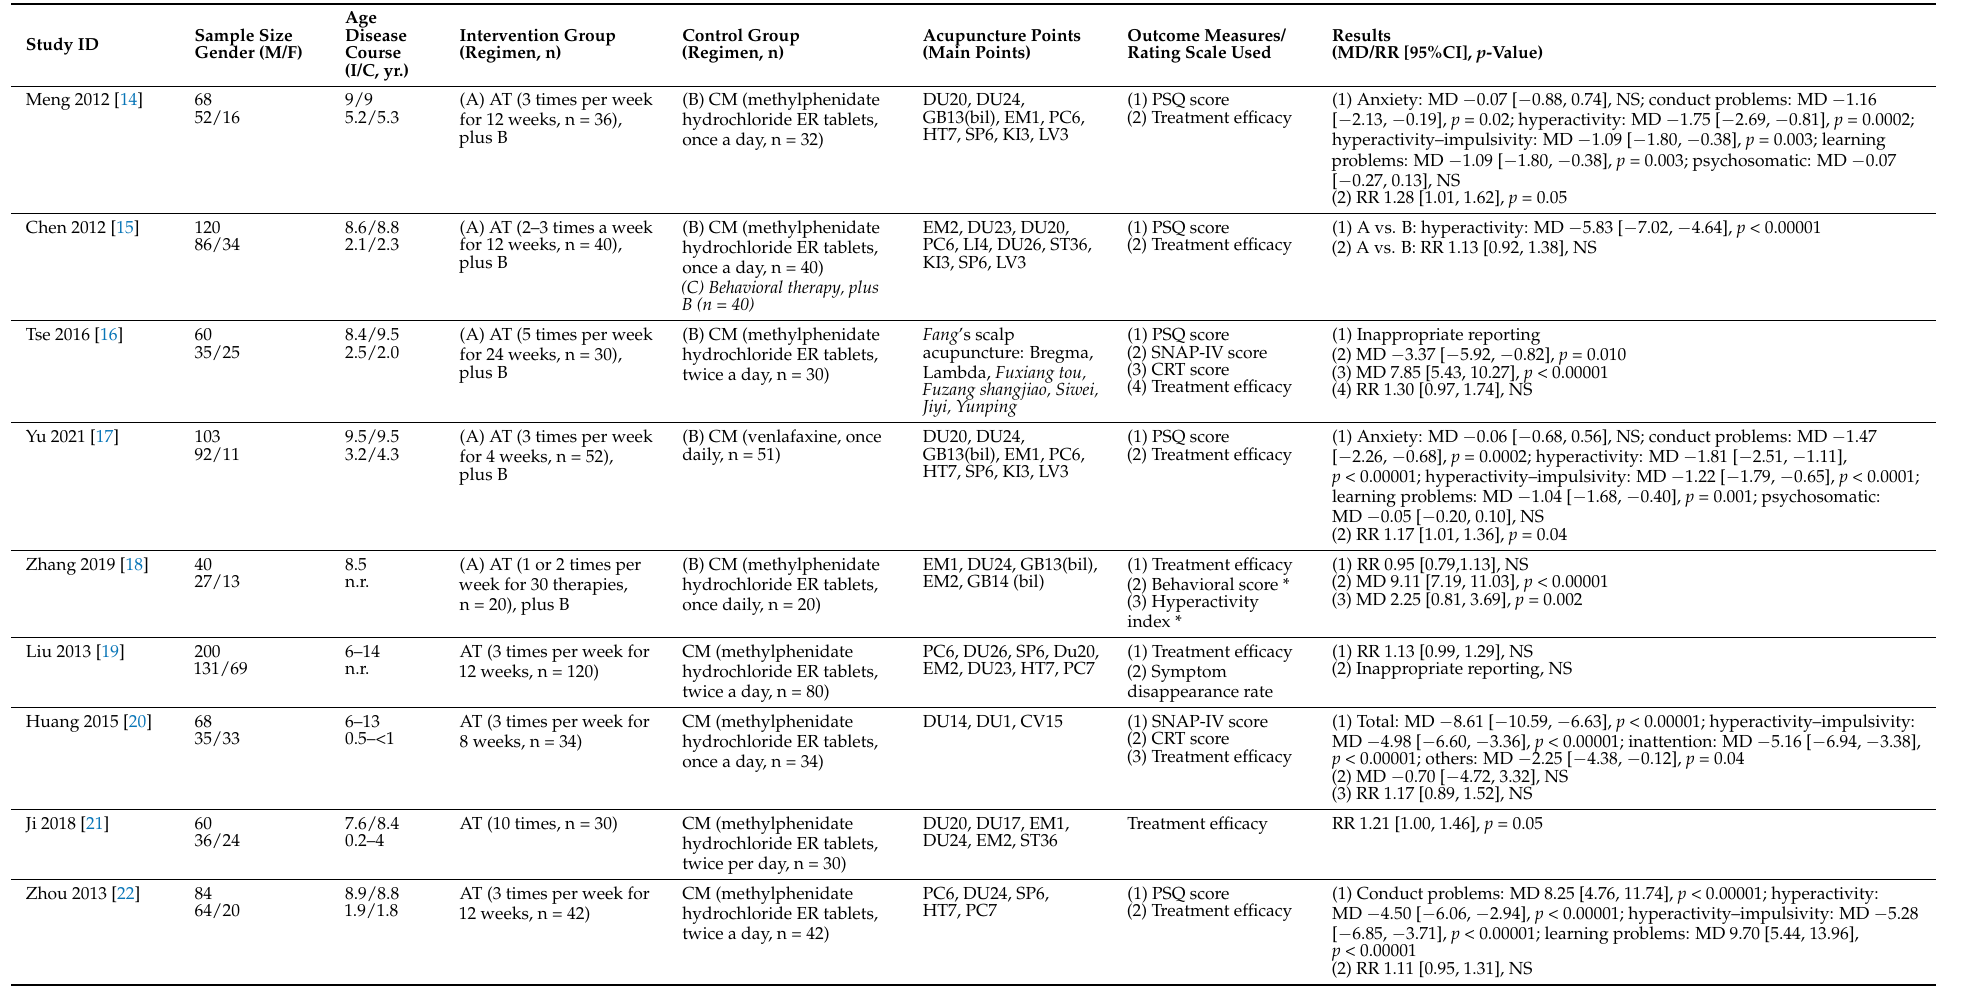
Table 1. Study characteristics of the included